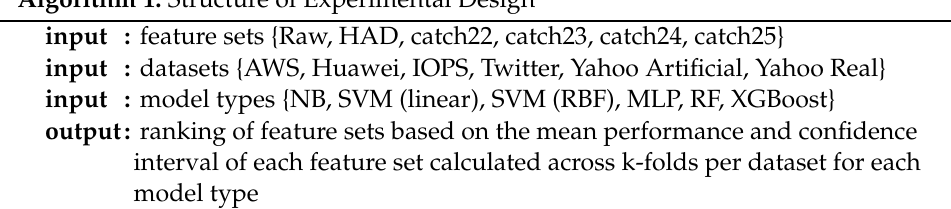
Algorithm 1: Structure of Experimental